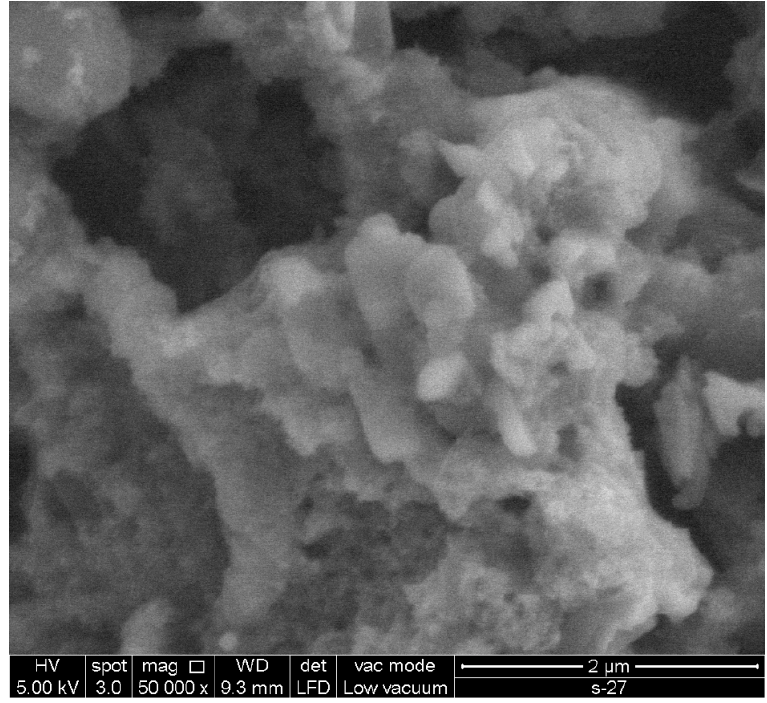
Figure 7. Agglomeration of ADN particles.